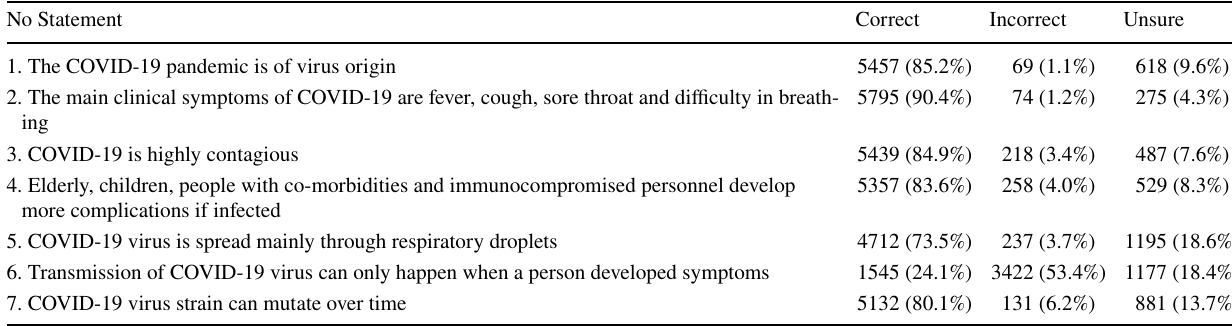
Table 2 Descriptive data of knowledge towards COVID19 No Statement